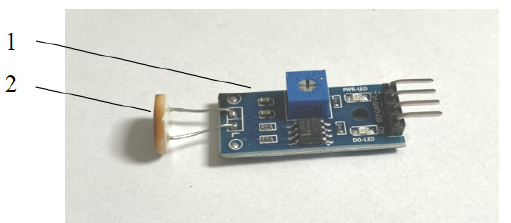
Figure 3. Structure of the feedback monitoring device: 1. signal processing device. 2. photosensitive sensor.